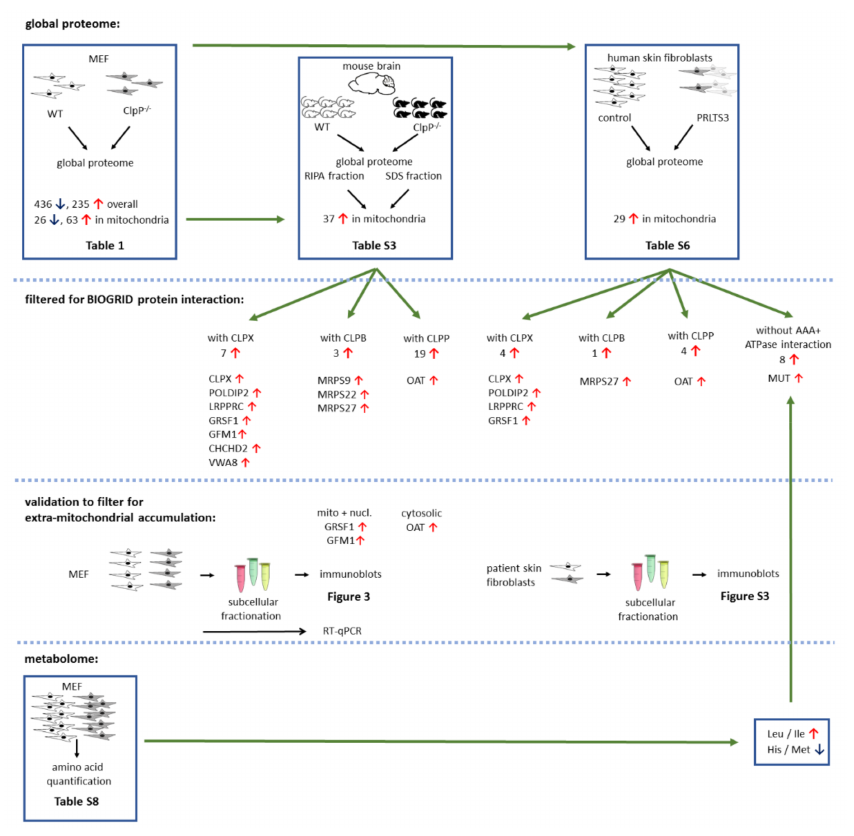
Figure 1. Schematic overview of experimental setup and main findings. Numbers represent amount of dysregulated factors, red arrows pointing up indicate significant upregulations, and blue arrows pointing down indicate downregulations. Number of biological replicates (different cell lines or mice) is represented by non-overlapping symbols, and cell line triplicates are shown as